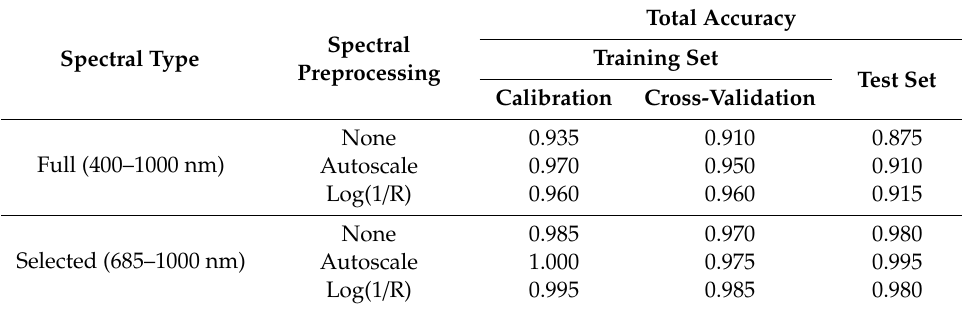
Table1. Totalclassificationresultsforrecognitionofblueberrybasedonpartialleastsquaresdiscriminant analysis models over the spectral range of 400–1000 nm and 685–1000 nm.